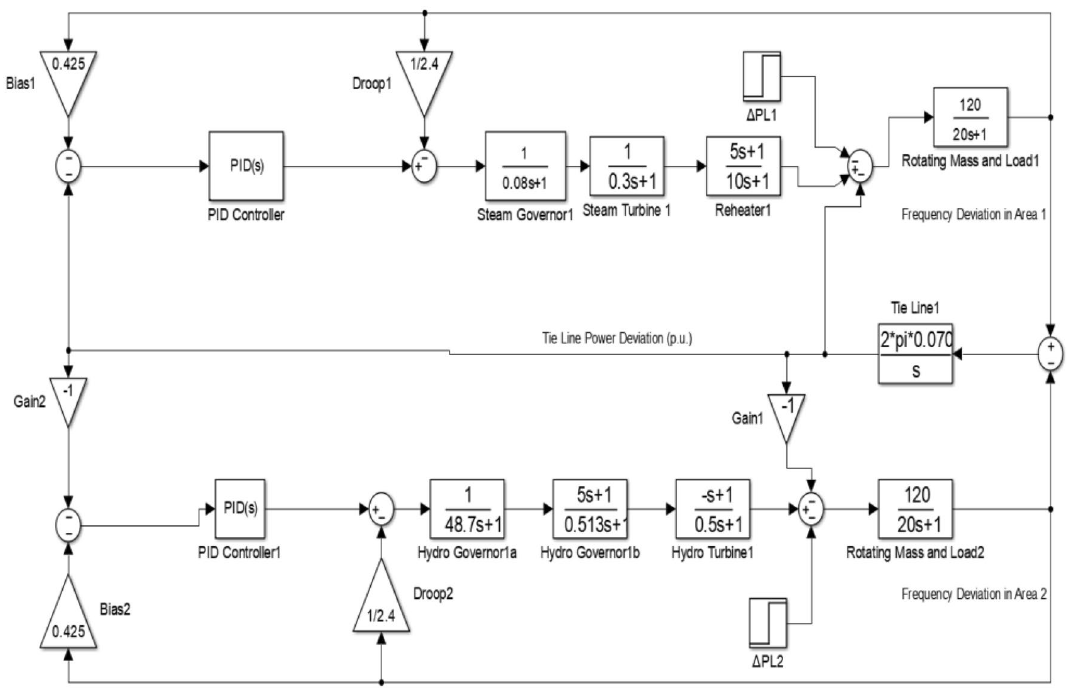
Fig. 1 Linear two-area system